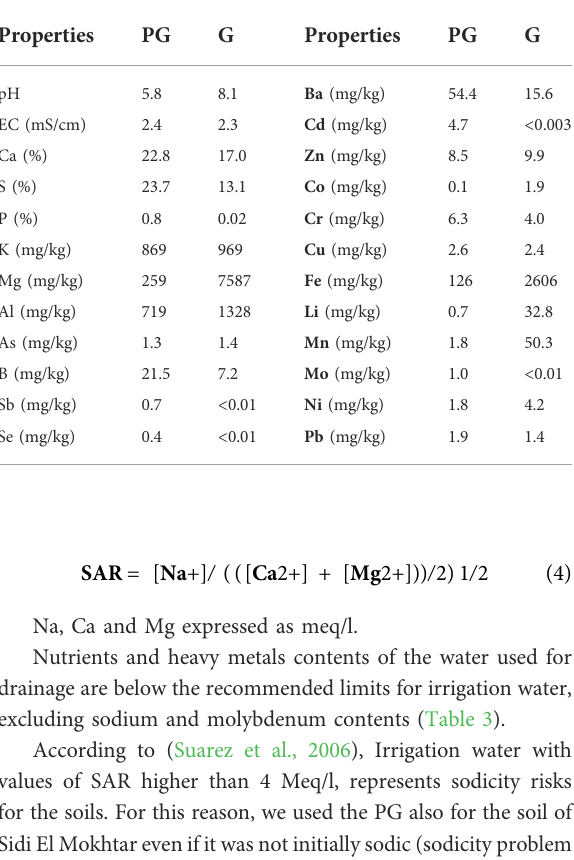
TABLE 2 PG and G chemical